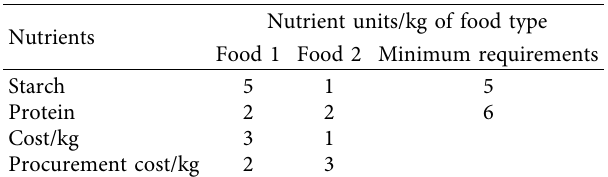
Table 3: Data considered by the manager. Nutrients